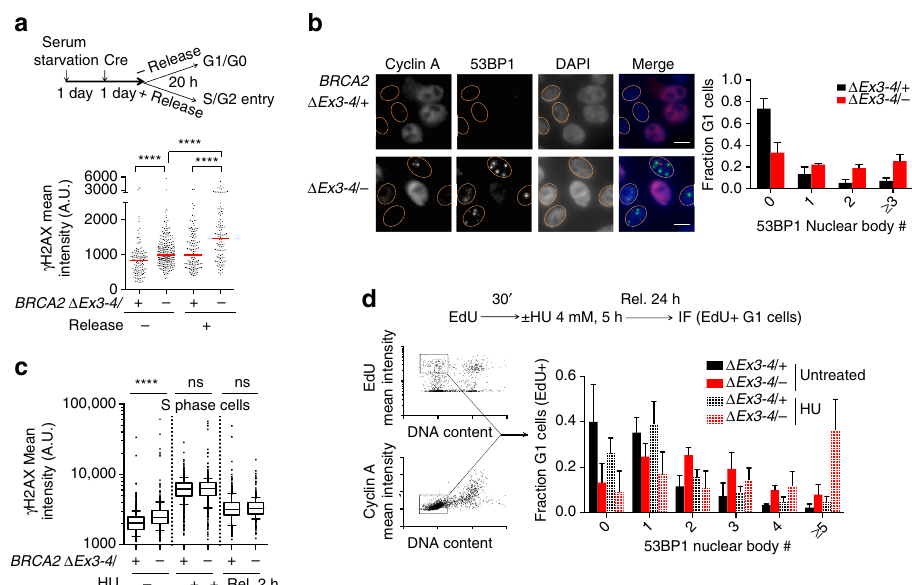
Fig. 4 BRCA2 suppresses replication stress associated with G1 53BP1 nuclear bodies. a BRCA2 Δ Ex3-4/ – cells were serum starved with or without release, as in the schematic ( top ), and γ H2AX mean nuclear intensities were quanti fi ed ( bottom ). γ H2AX mean nuclear intensities are shown from one experiment, which is representative of two independent experiments. Median γ H2AX intensity, red bars . b 53BP1 nuclear body analysis in G1 phase. Cyclin A – nuclei (indicating G1 phase) are outlined ( left ). Quanti fi cation of 53BP1 nuclear body distribution is shown ( right ). n = 4. Scale bars 10 µ m. c S phase DNA damage analysis. Where indicated, cells were treated with EdU for 30 min followed by HU treatment (4 mM, 5 h) with or without release (Rel.) before harvest. Quanti fi cation of γ H2AX mean nuclear intensities is shown from one experiment, which is representative of two independent experiments. Box and whiskers show the 10th and 90th percentiles. d HU-induced 53BP1 nuclear body formation analysis, as in the schematic ( top ). Sample plots for high content image cytometry analysis are shown on the left . The EdU+ G1 cell fraction (i.e., EdU+, cyclin A – , 1N DNA content) for 53BP1 nuclear body quanti fi cation is highlighted. Quanti fi cation of 53BP1 nuclear body distribution in EdU+ cells in G1 at the time of harvest is shown in the graph. n ≥ 3. Error bars s.d. ns,